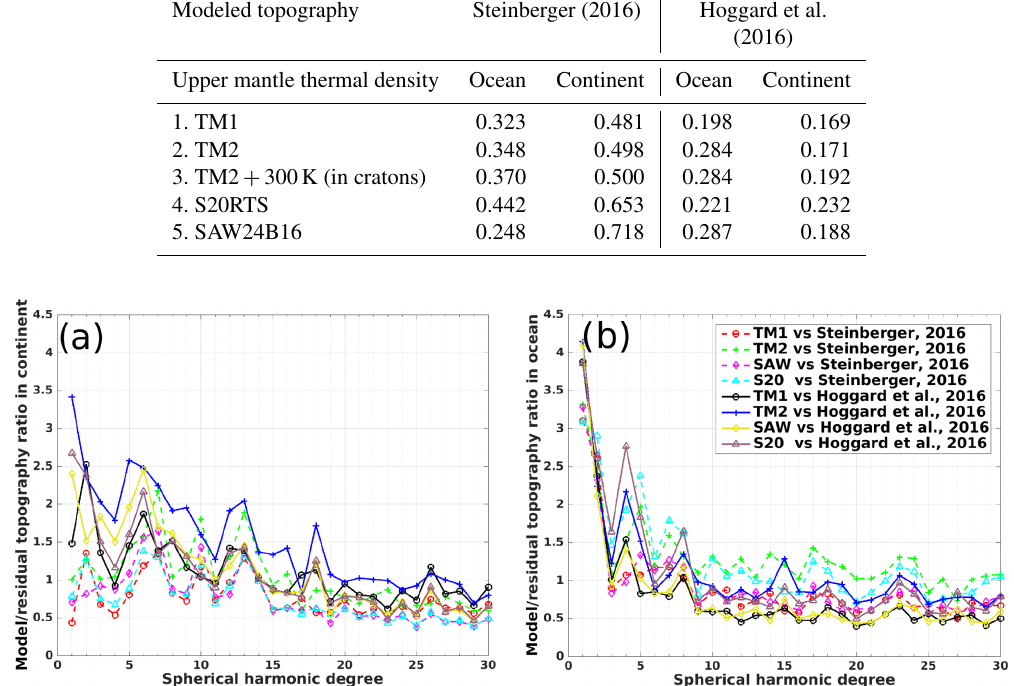
Figure 10. Ratio of modeled dynamic topography from TM1, TM2, SAW24B16 and S20RTS for (a) continental and (b) oceanic regions with observation-based residual topography from Steinberger (2016) and Hoggard et al.